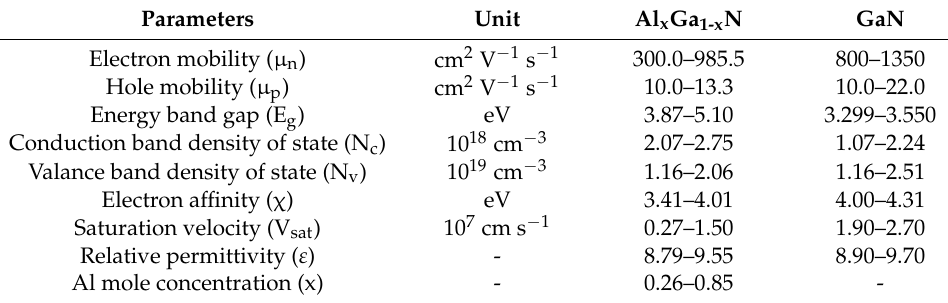
Table 1. Material parameters of GaN/AlGaN